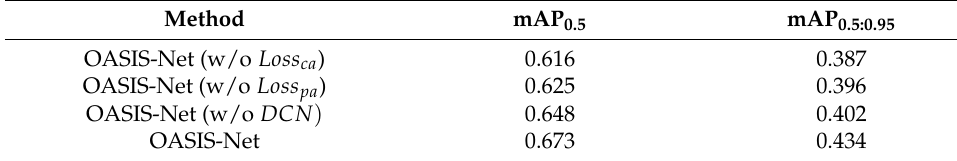
Table 6. Ablation study results of OASIS-Net for crack